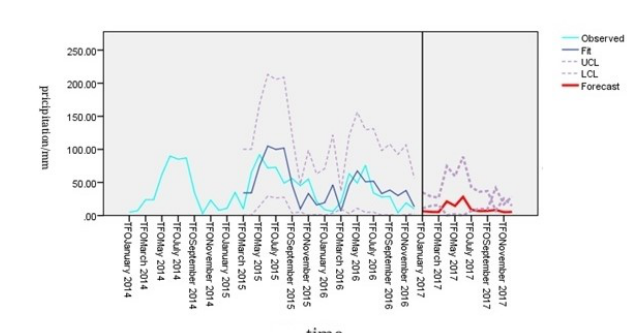
Figure 1. Figure forecast model of monthly maximum precipitation in Guilin from 2014 to 2017